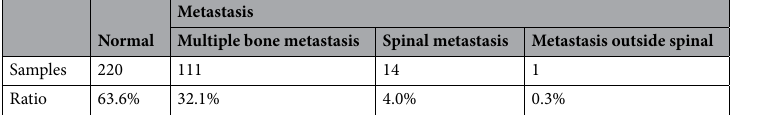
Table 1. Statistics of the image dataset of whole-body SPECT bone scan (n = 346).